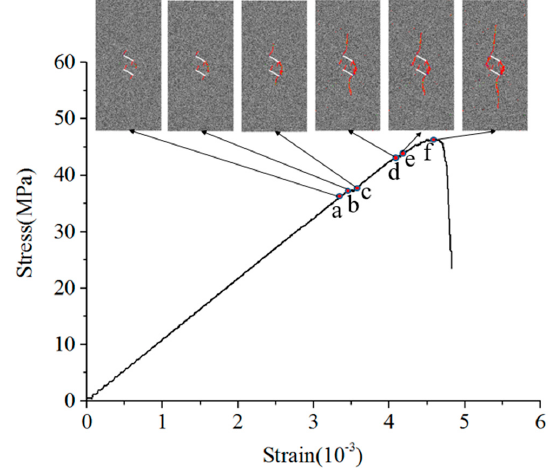
Figure 6. The stress-strain curve of a specimen under uniaxial compression. (Here, the dip angle of the flaws is 𝛼 = 30 ° . The points a, b, c, d, e and f correspond to different loading stages respectively.). The velocity fields and the strain rate tensors in the measurement circle at the different loading stages are shown in Figures 7 and 8. The velocity of the particles in Figure 7 is denoted by the black line with arrows and the thick black arrow represents the relative motion of the particles near the crack. The main strain rate tensor in Figure 8 is denoted by two sets of light green lines with arrows, with the direction and length of the arrows indicating the direction and relative size of the main strain rate, respectively. Table 4 shows the values of variable R in the measurement circle at different loading stages. The corresponding R values in the measurement circle ① and ② are recorded as 𝑅 (cid:2869) and 𝑅 (cid:2870) , and the short dash line in Table 4 represents no secondary cracks at different loading stages.